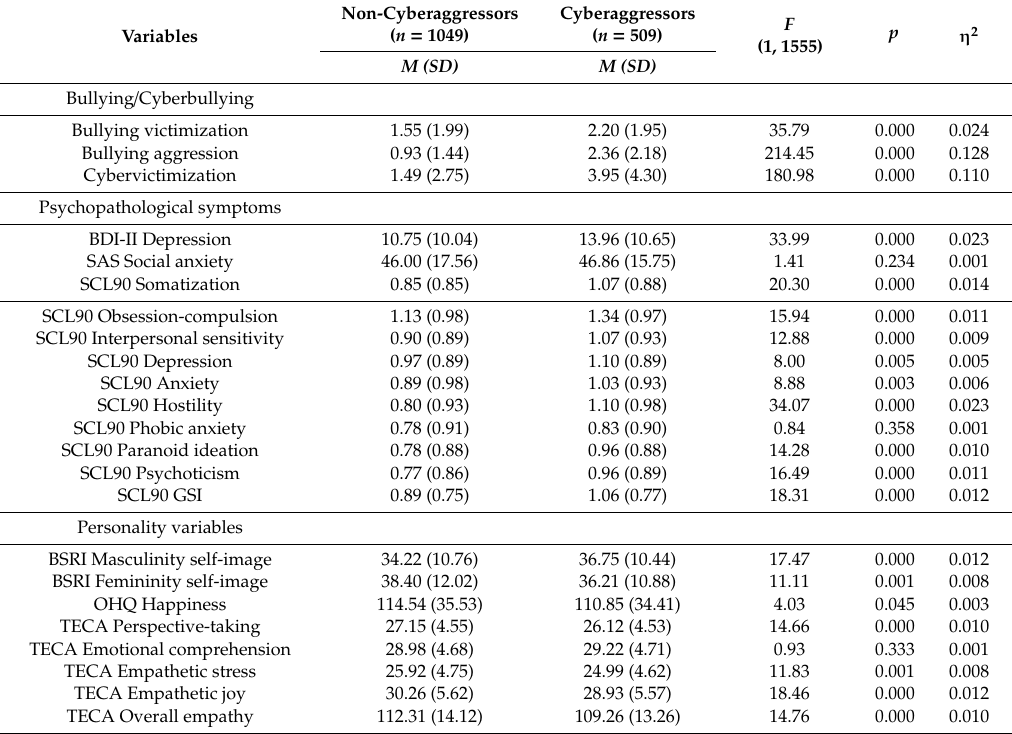
Table 1. Means and standard deviations in all variables in the two profiles (non-cyberaggressor, cyberaggressor), results of analyses of variance as a function of profile, and e ff ect size ( η 2